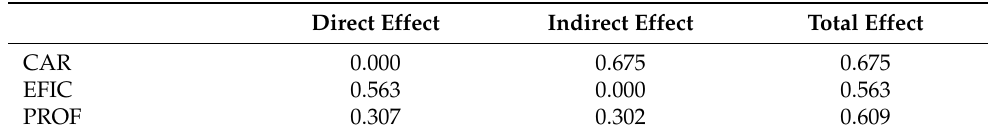
Table 7. Effects of predictor variables.